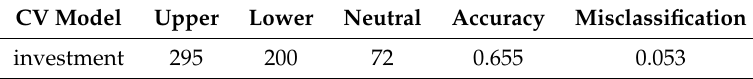
Table 1. Description of CV models and training